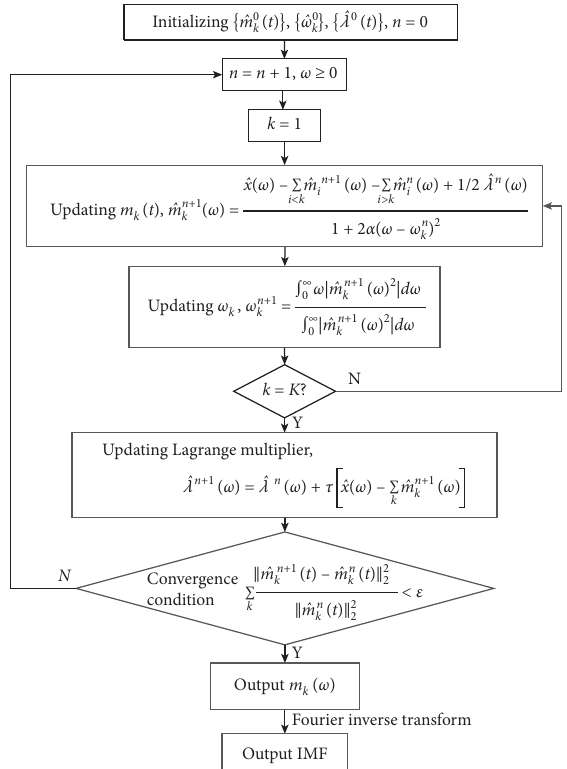
Figure 9: Flowchart of VMD algorithm.